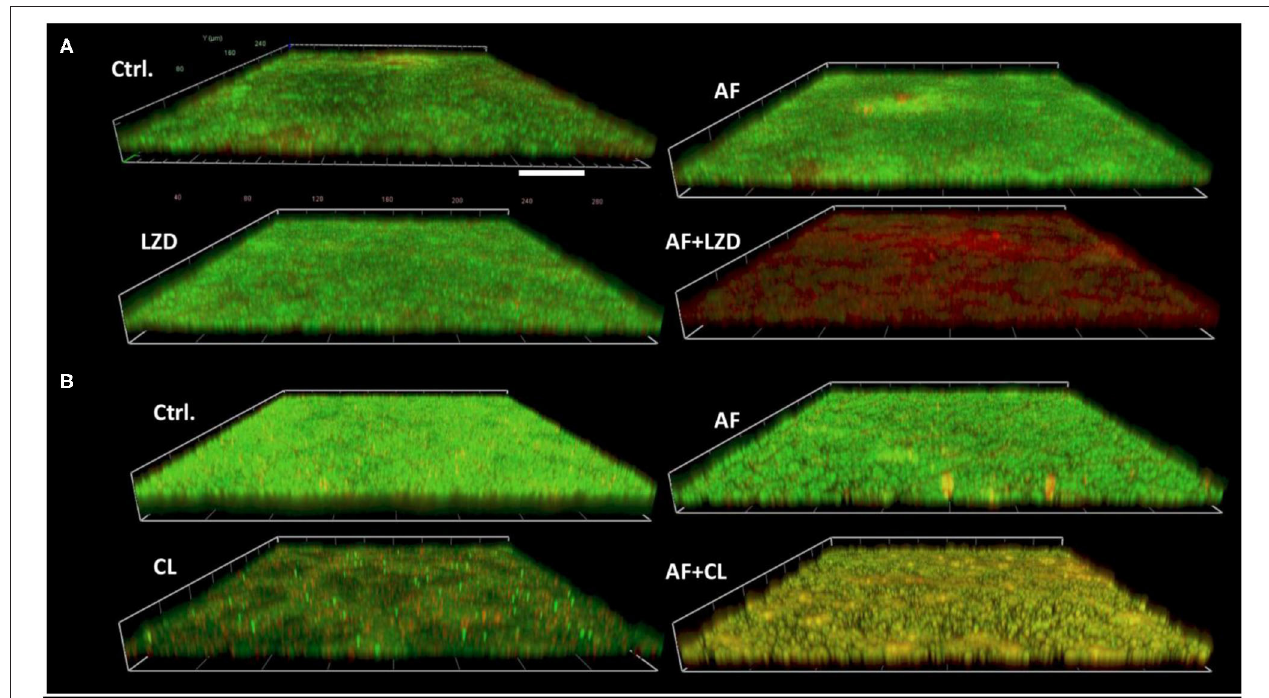
FIGURE 2 | Demonstrative CLSM images of biofilm eradication by AF mono-/combination treatment. Biofilms were performed on glass cover slides and then treated with AF and antibiotics alone and/or in combination for 24h. The cover slides were stained with the fluorescent dye mixture of SYTO9 (live cells, green) and PI (dead cells, red). (A) S. aureus LZB1, AF 8 mg/L, LZD 16 mg/L. (B) E. faecalis ATCC29212, AF 2 mg/L, CHL 8 mg/L. Scale bar: 40 µ